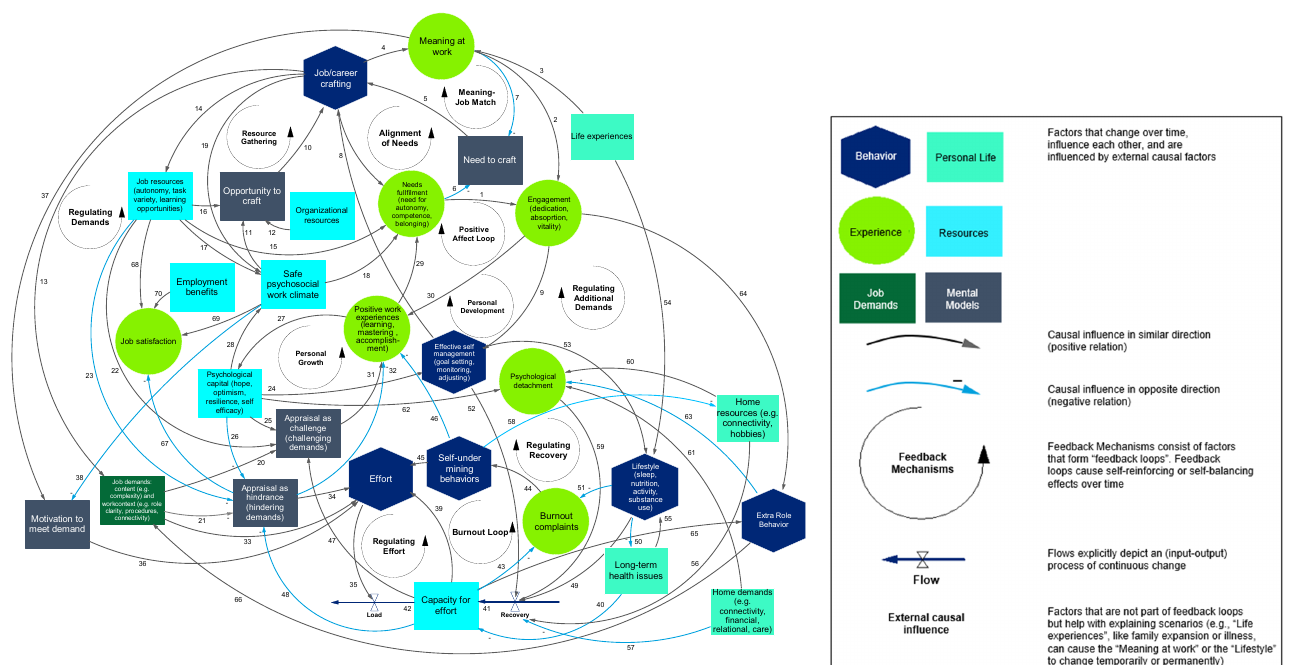
Figure 1. Causal loop diagram of individual workplace well-being. The model consists of several measurable variables classified as aspects of behavior, personal life, experience, resources, job demands, and mental models. Variables are connected with arrows indicating the direction of the causal relationship. Black and blue arrows indicate a positive (reinforcing) and negative (counteracting) causal relationship between variables, respectively. Every causal relationship is numbered to clarify them in the text as links . Feedback mechanisms are indicated as circle-arrows in black and are identified with their corresponding names.